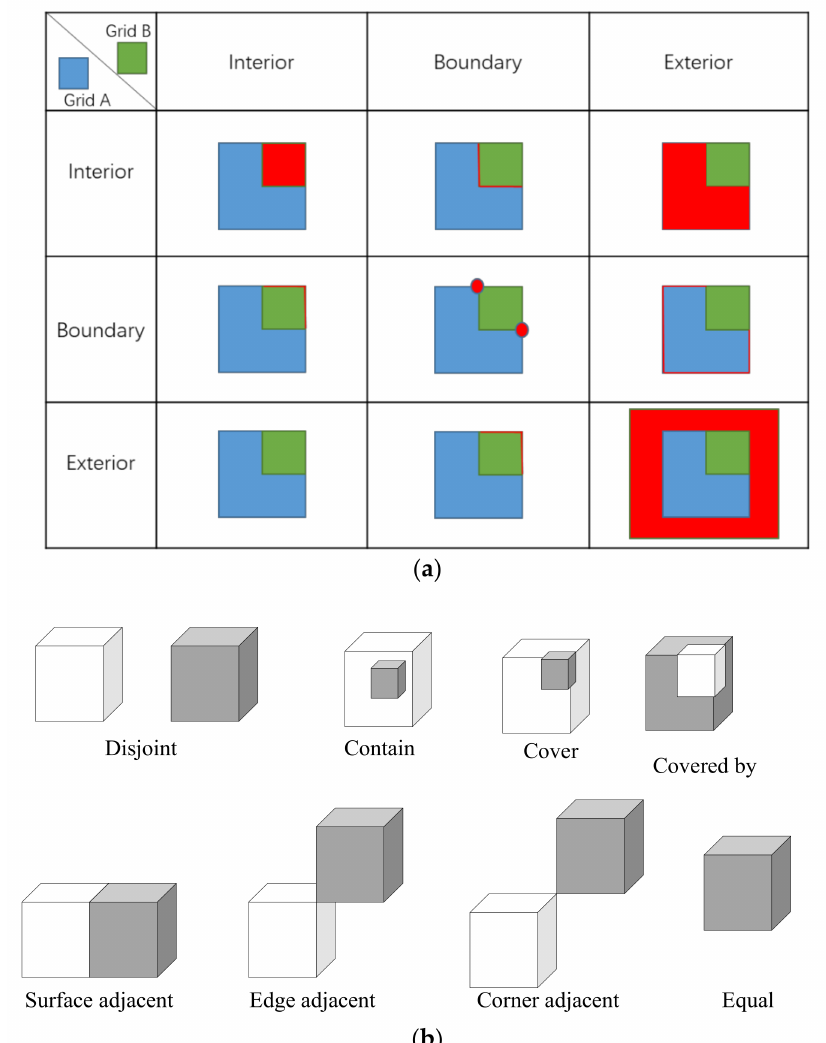
Figure 12. Spatial topological relationship between grids. ( a ) Correspondence with DE-9IM; ( b ) spa- tial topological relationship between grids